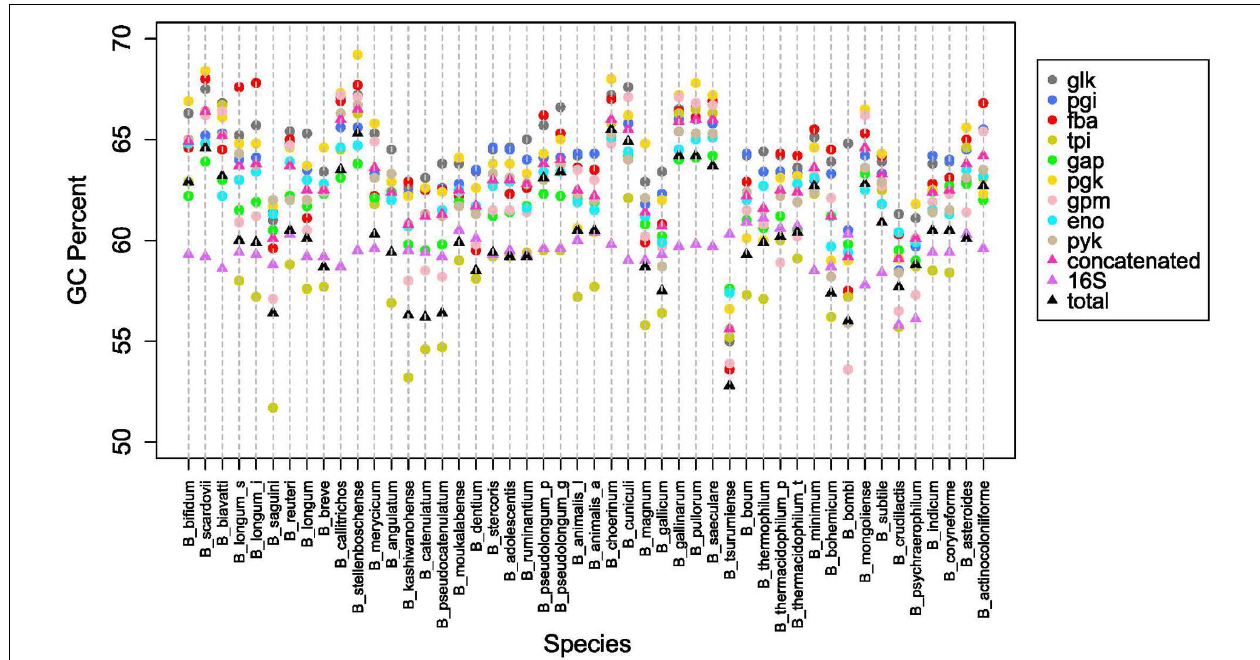
FIGURE 5 | Overall GC content patterns across species. GC percent for each glycolysis gene, 16SrRNA and overall genome, for species listed in Table 1 .